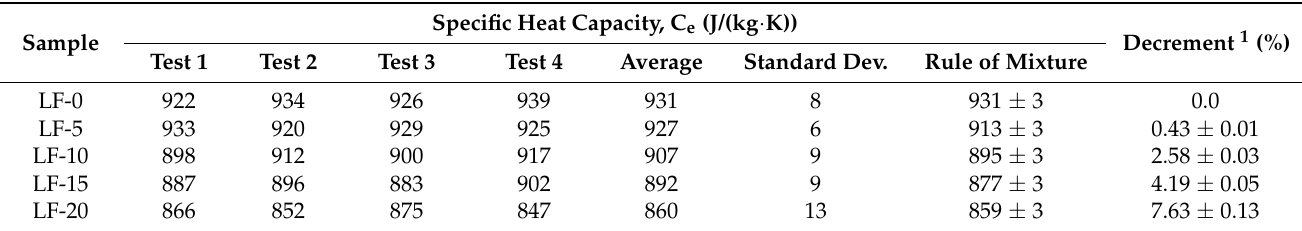
Table 5. Specific heat capacity values, C e , calculated from MDSC measurements.